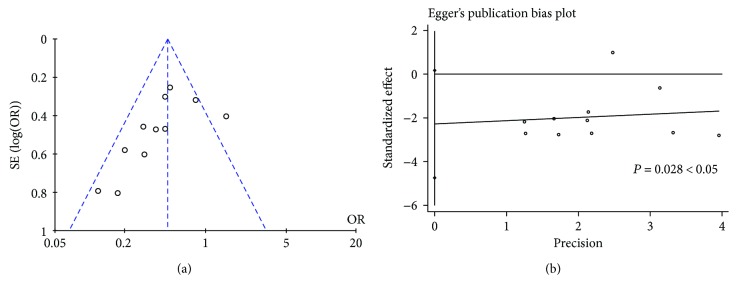
Bias assessment plot for the effect of rectal administration of NSAIDs in preventing PEP by a funnel plot (a) and Egger's test (b).